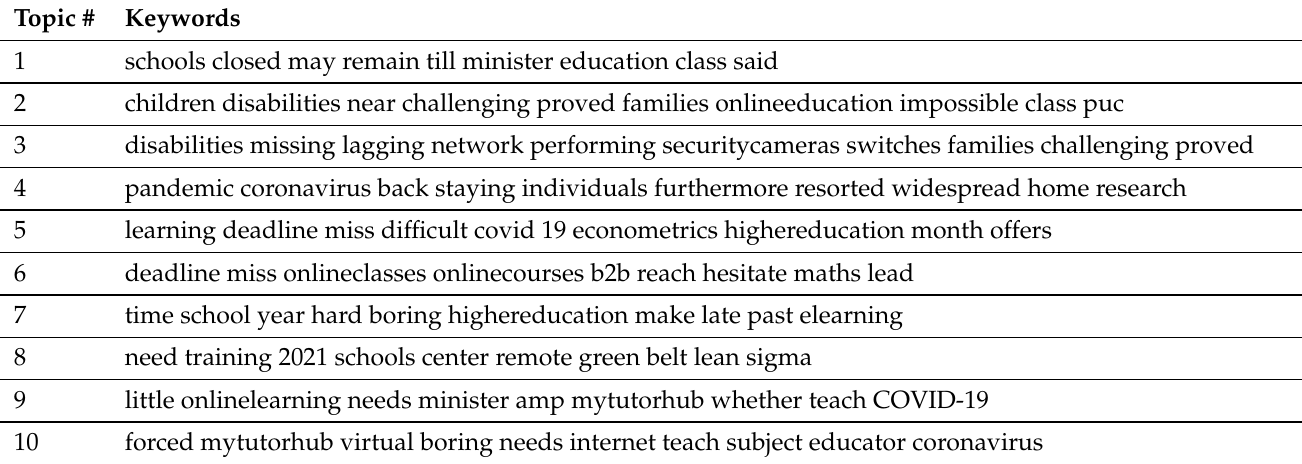
Table 21. Topic modeling with LSA for negative